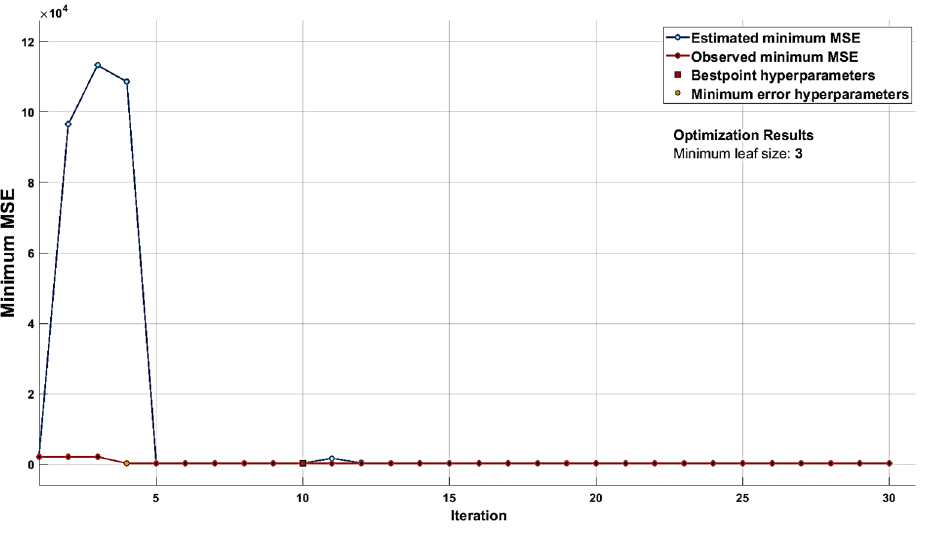
Figure 12. Cross-Validation using MSE of OBRM1 for CO2. The tracking and alignment performed by OBRM3 for the observed and predicted CO2 (PPM) is up to 4400 ppm in Figure 13.